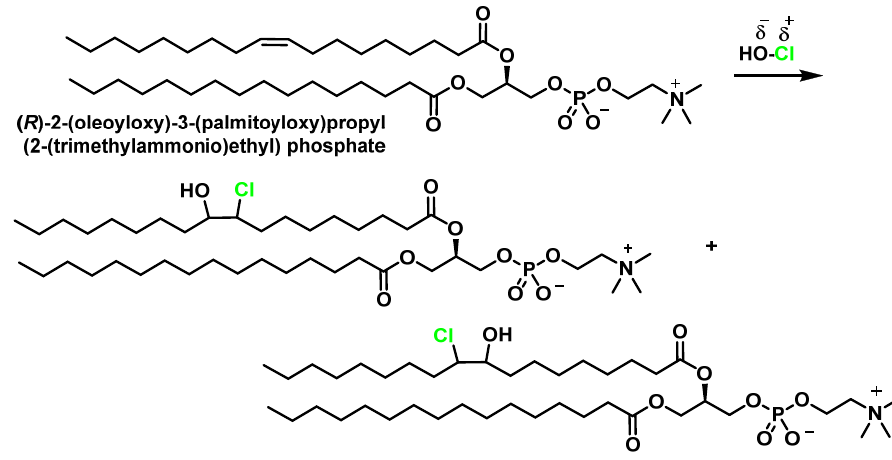
Figure 13. Scheme of reaction of phosphatidylcholine with HOCl.